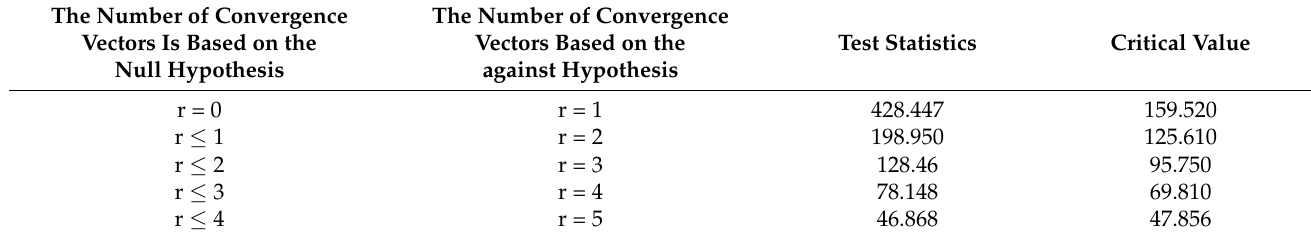
Table 7. The results of the cointegrated test based on trace